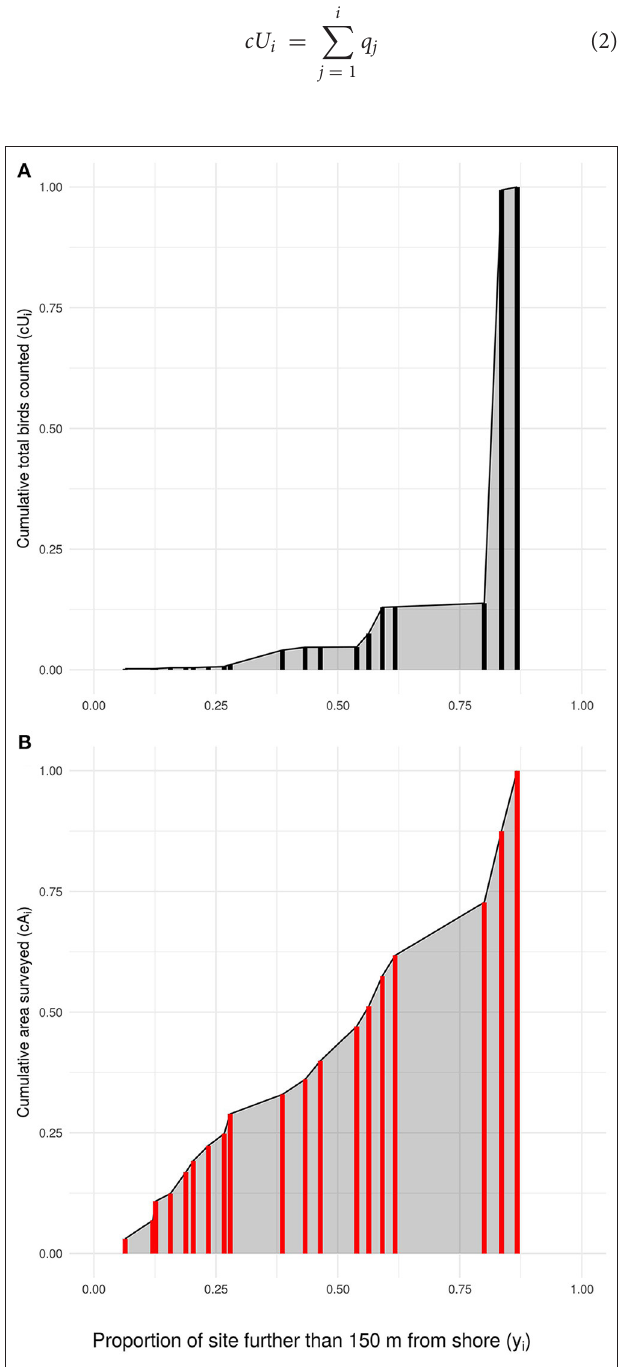
FIGURE 5 | How the Priority Matching Distribution index is calculated, using 1985 in this example. The locations (red and black bars; locations with equivalent safety are stacked) surveyed in a year are ordered along the x-axis from lowest to highest safety index ( y i ), with the cumulative proportional usage ( A : numerator of the PMD index), and intertidal area ( B : denominator of the PMD index) shown by the height of the vertical bar. The gray area in each plot shows the area under the curve (AUC) used to calculate the PMD